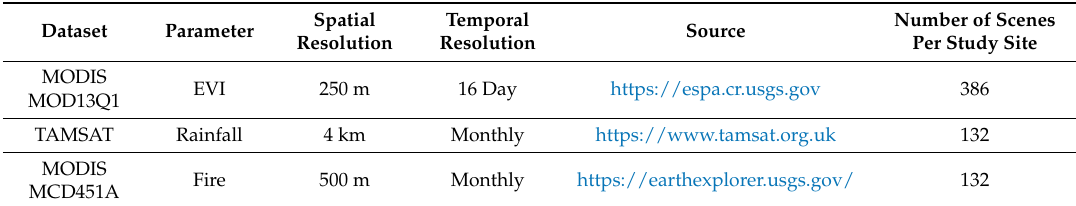
Table 1. Datasets used for the change